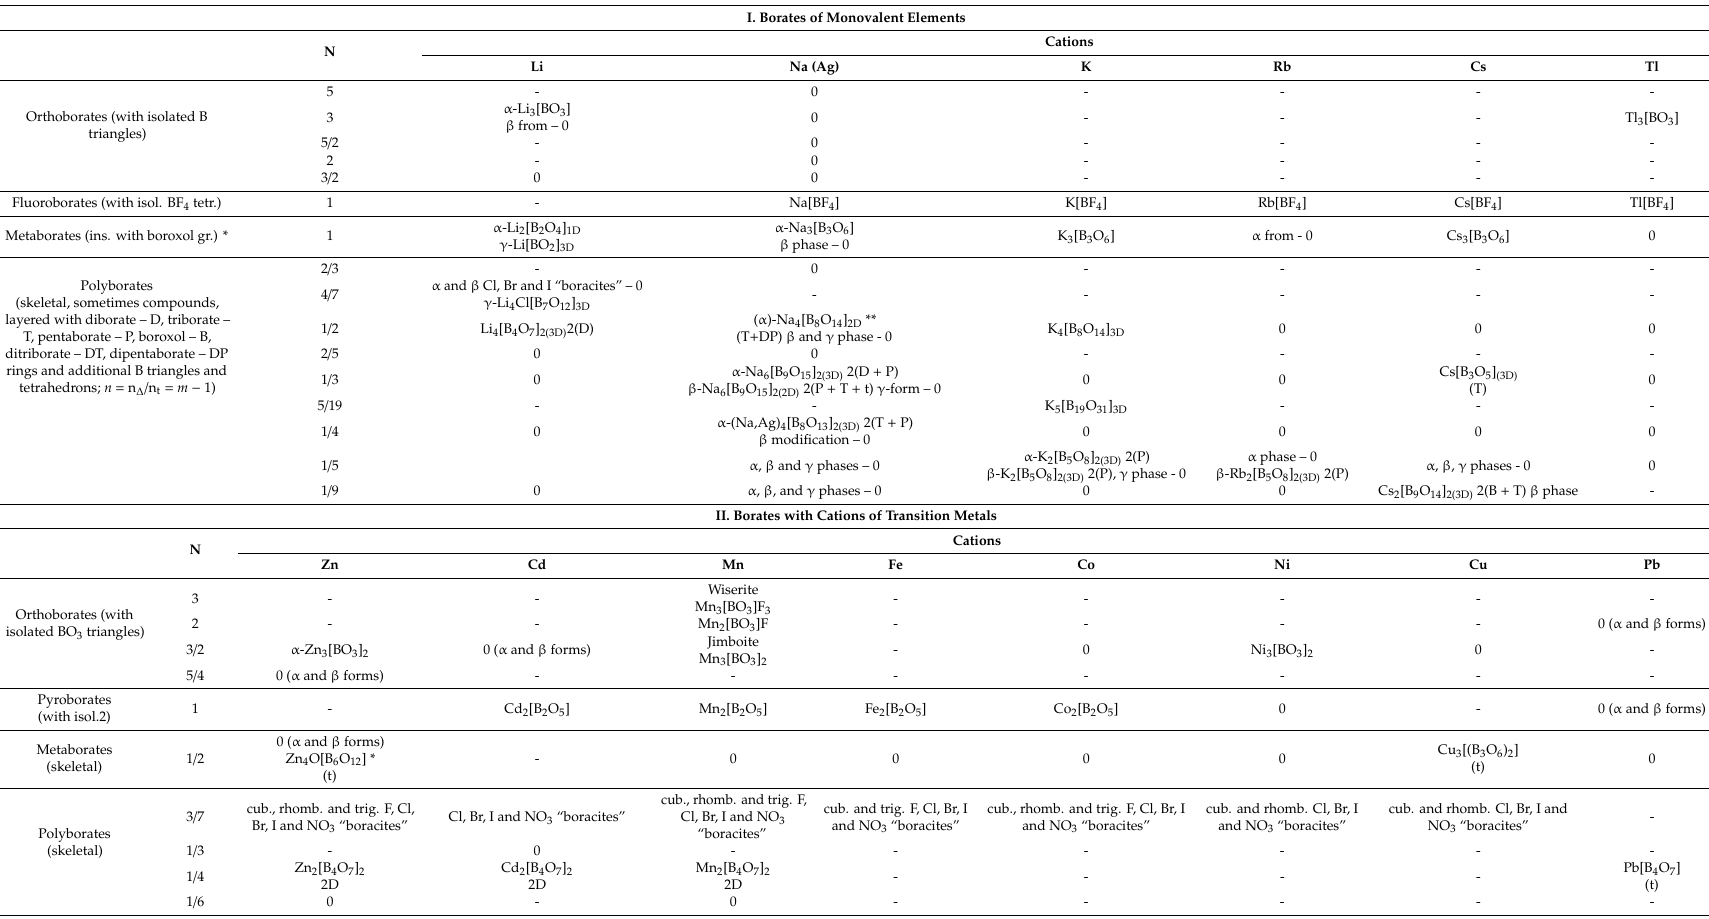
Table 6. Classification of mono- and divalent metal